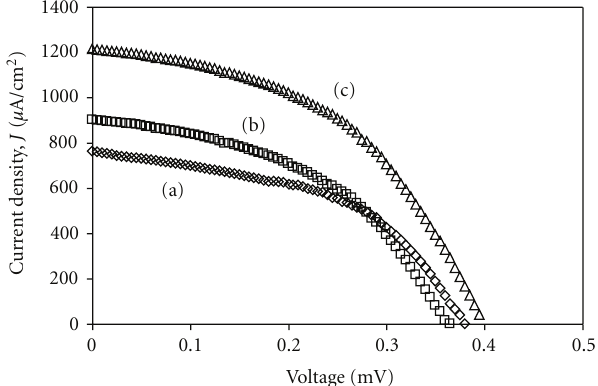
Figure 5: J - V characteristics of black rice DSSC with electrolytes having (a) 27.5 wt. % chitosan-22.5 wt. % NH 4 I(+I 2 ) + 50wt. % IL (b) 11wt. % chitosan-9wt. % NH 4 I-80wt. % BMII, and (c) 11wt. % (chitosan :PEO, wt ratio 30:70)-9wt. % NH 4 I-80wt. % BMII electrolyte (in gel form).